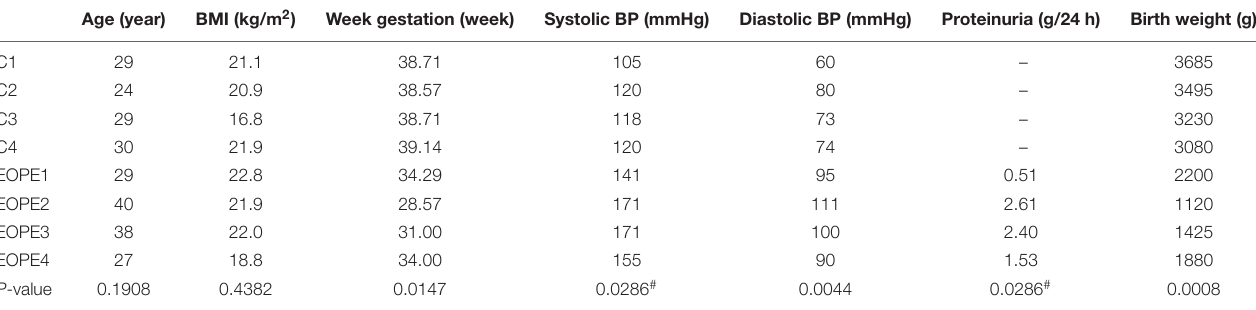
TABLE 1 | Clinical characteristics of EOPE and controls for microarray.